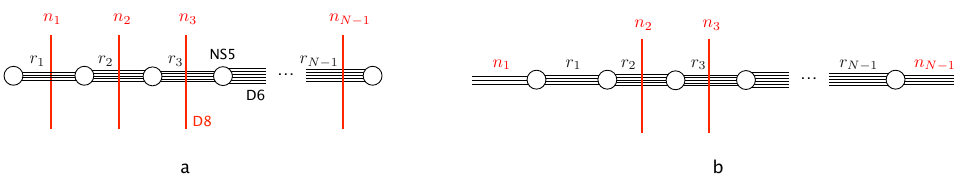
Figure 2 . Brane con(cid:12)gurations for linear quivers. In (b) the (cid:12)rst and last stacks of (cid:13)avor D8-branes of (a) are replaced by semi-in(cid:12)nite